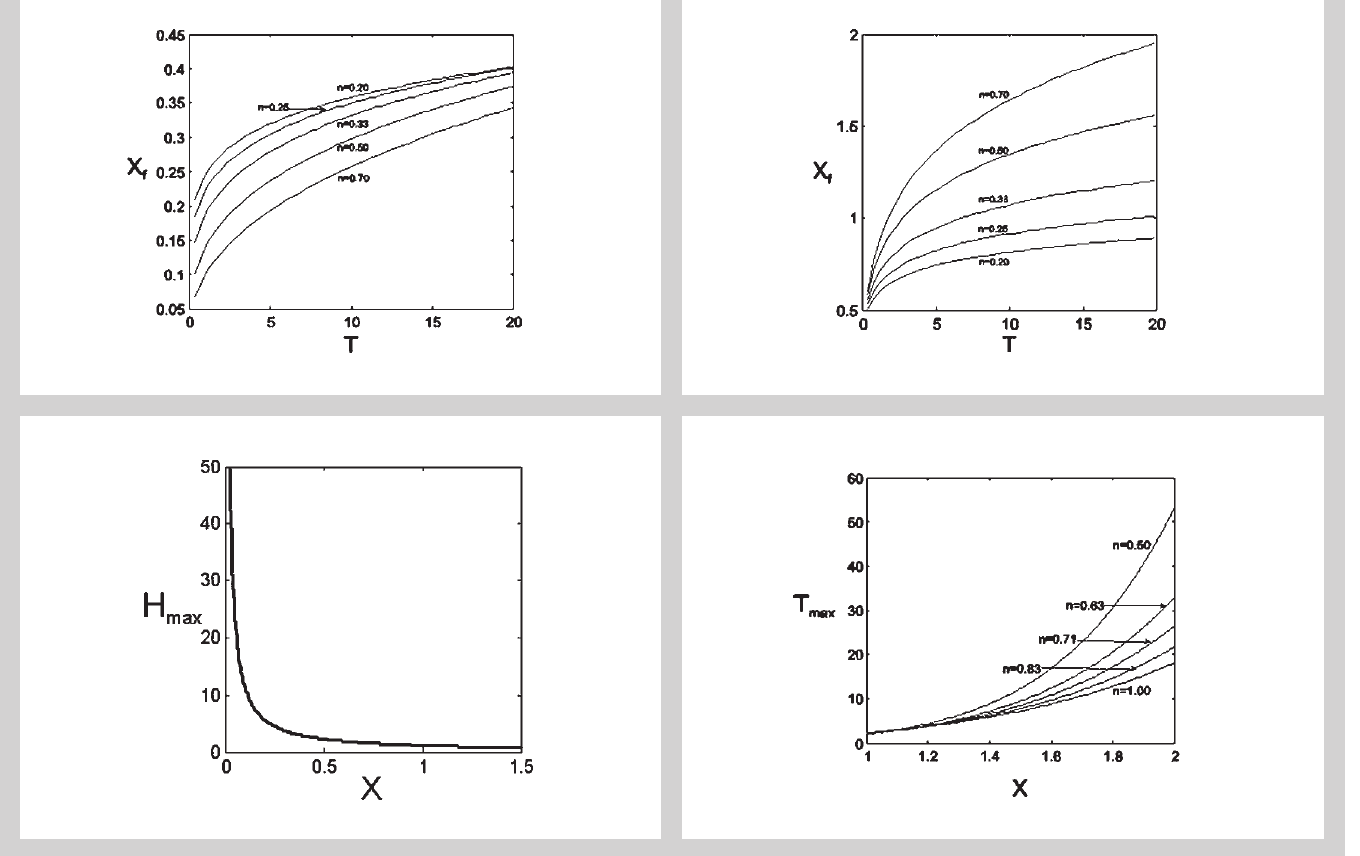
Figure 6 (above): Evolution of the front of the positive wave front for assigned power law index in short time viscous regime (a) and in the long time regime (b). Figure 7 (left below): Variation of the maximum height at given station, vs the corresponding abscissa. Figure 8 (right below): Variation of the time of occurrence of maximum height for given abscissa for given power law